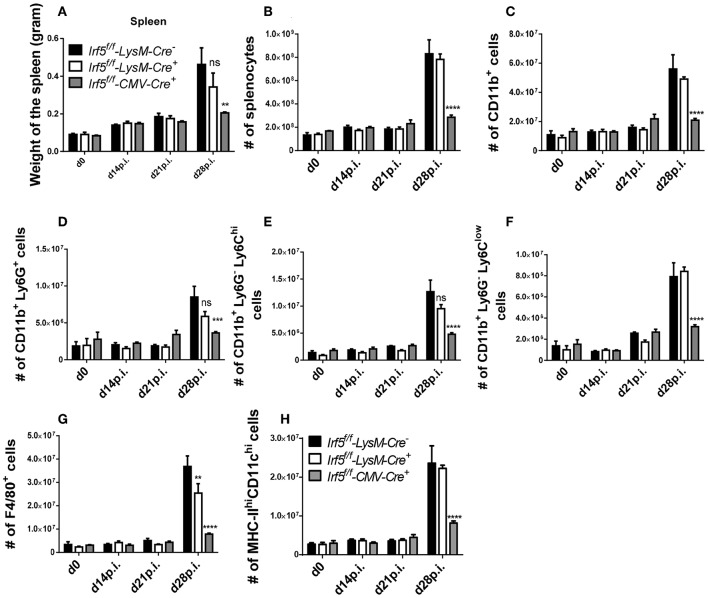
Irf5f/f -LysM-Cre+ mice develop splenomegaly following L. donovani infection. Irf5f/f
-LysM-Cre−, Irf5f/f
-LysM-Cre+, and Irf5f/f
-CMV-Cre+ mice were infected with L. donovani and sacrificed at d14, d21, and d28 p.i. Graphs show spleen weights (A), number of splenocytes (B) and absolute number of splenic CD11b+ cells (C) in naïve and infected mice over the course of infection. Splenocytes were stained with different surface markers; neutrophils were excluded before analyzing monocytes and monocyte-derived cells. Graphs show absolute number of Ly6G+ neutrophils (D), Ly6Chigh monocytes (E), Ly6Clow monocytes (F), F4/80+ cells (G), and MHC-IIhigh CD11chigh cells (H). Data is shown as the mean ± SEM, N = 3–4, one of 5 independent experiments is shown, ns, not significant, **p < 0.01, ***p < 0.001, ****p < 0.0001.